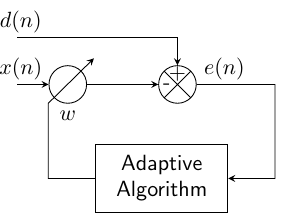
Figure 16. Schematic of an adaptive